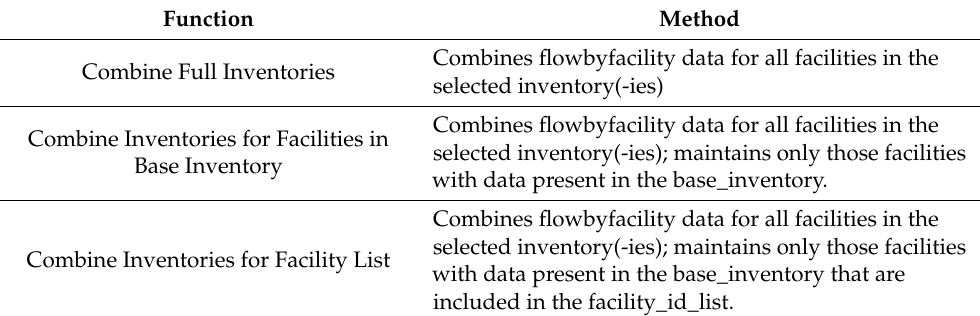
Table 5. Functions for combining inventories in stewicombo